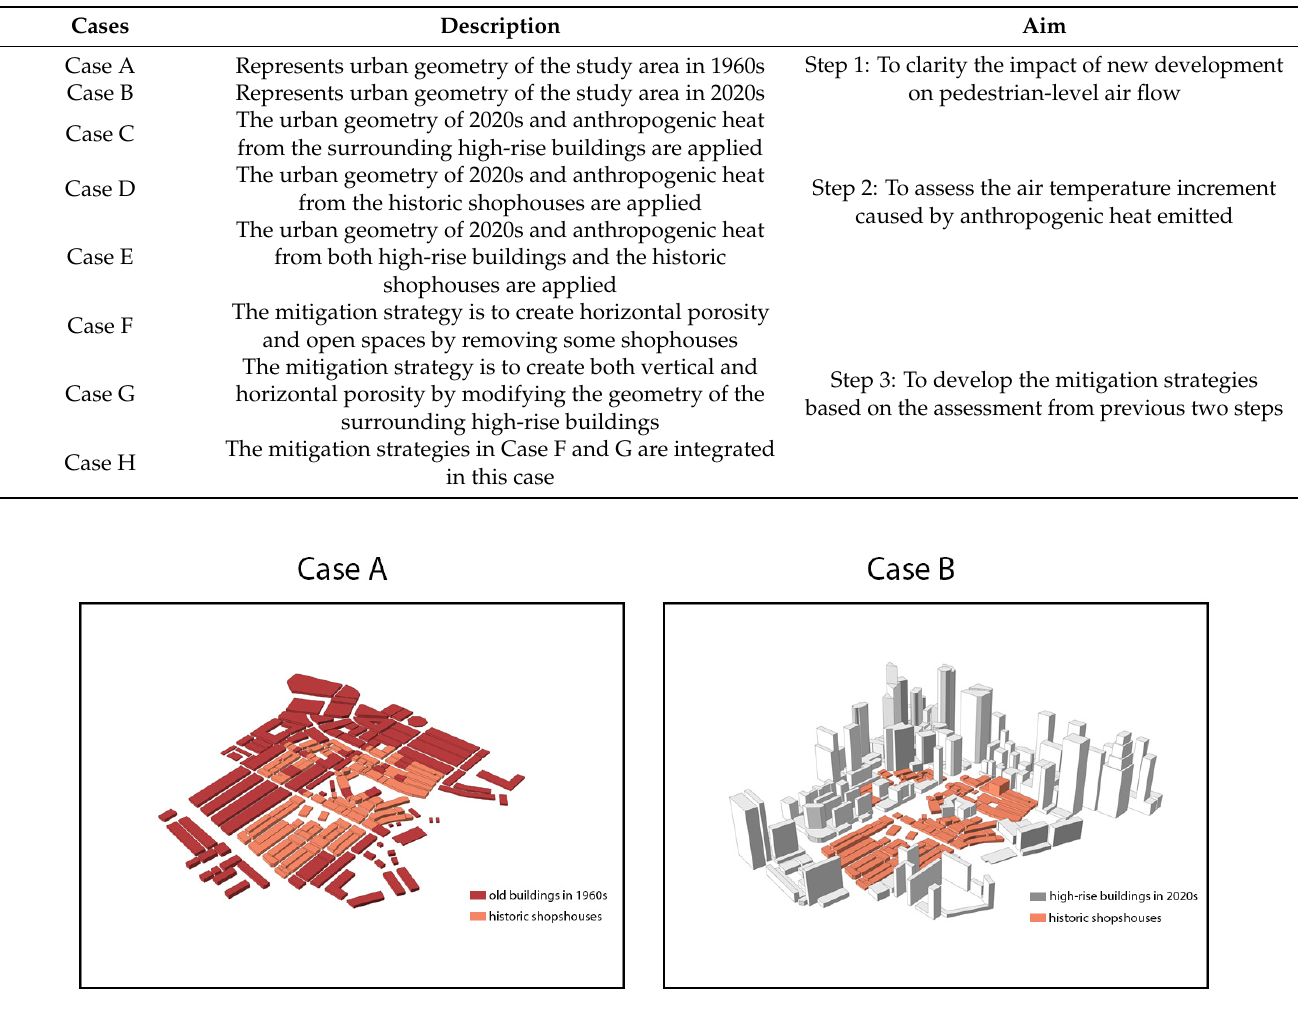
Table 1. Description of Case A-H and simulation aim of step 1–3.